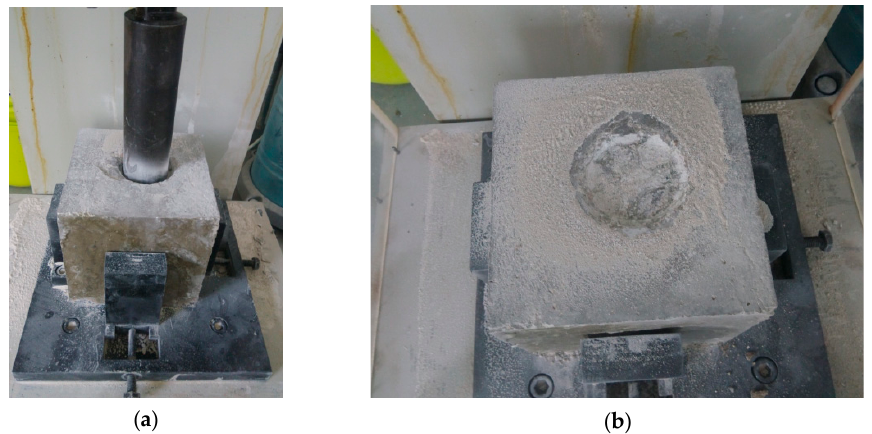
Figure 15. Appearance of specimens after 5000 blows. ( a ) Rammer penetrates into concrete; ( b ) State of specimen after 5000 blows.